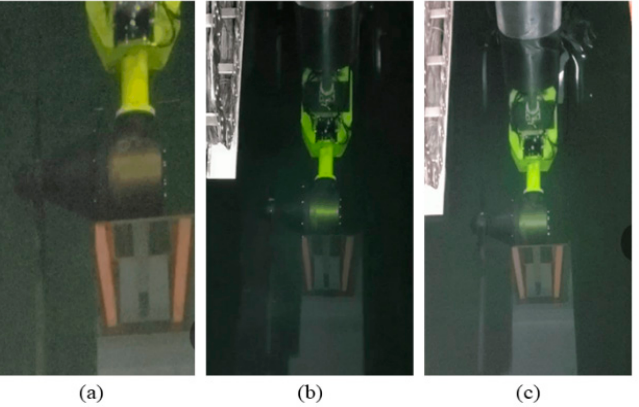
Figure 12. Towing test under different working conditions. ( a ) 0.1 m/s working condition; ( b ) 0.3 m/s working condition, ( c ) 0.5 m/s working condition.